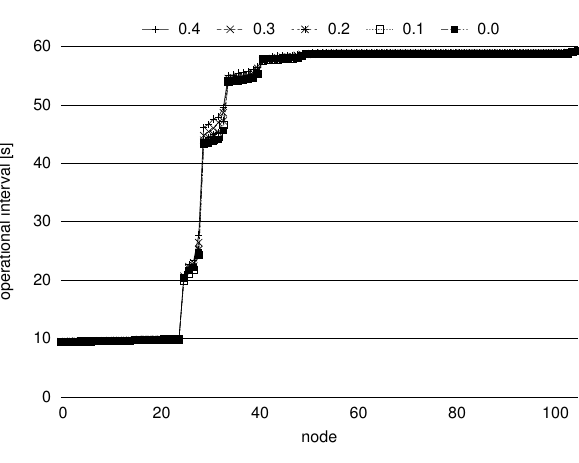
Figure 13. Operational interval with different packet loss